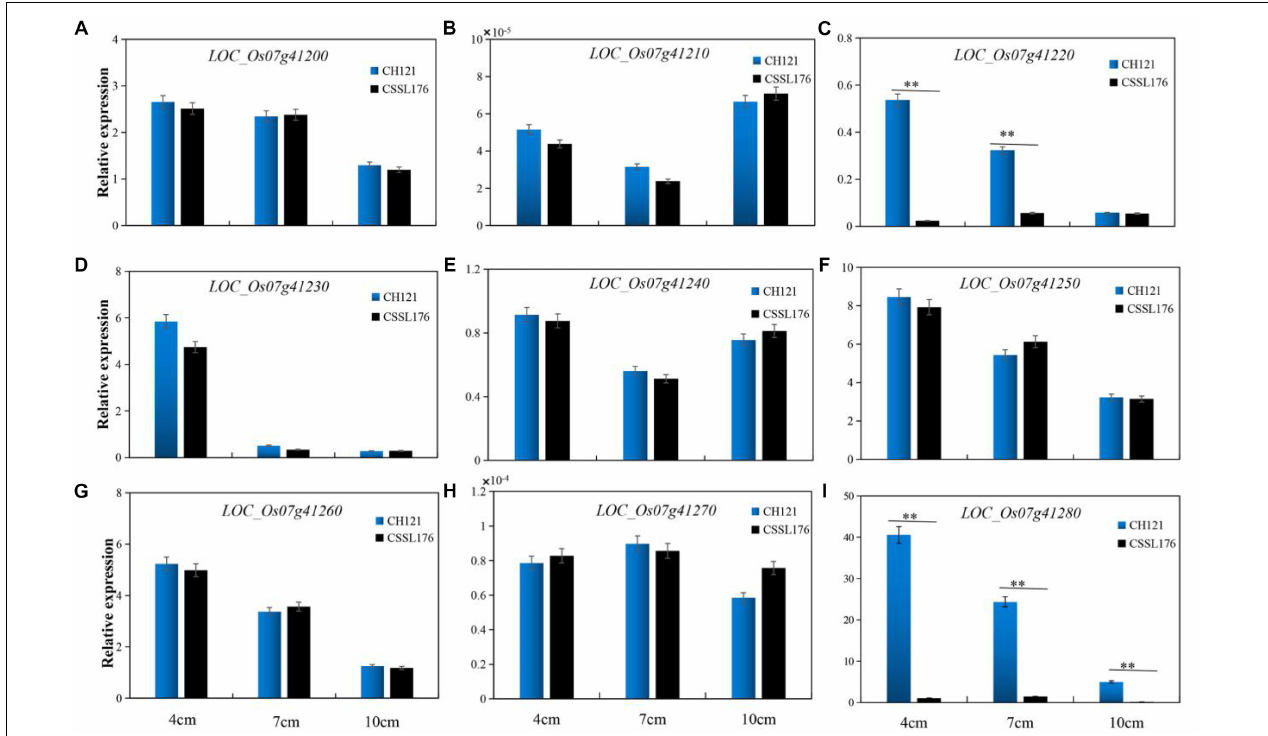
FIGURE 5 | The expression levels of (A) LOC_Os07g41200 , (B) LOC_Os07g41210 , (C) LOC_Os07g41220 , (D) LOC_Os07g41230 , (E) LOC_Os07g41240 , (F) LOC_Os07g41250 , (G) LOC_Os07g41260 , (H) LOC_Os07g41270 , (I) LOC_Os07g41280 between CH121 and CSSL176 in 4 cm, 7 cm, and 10 cm panicles,